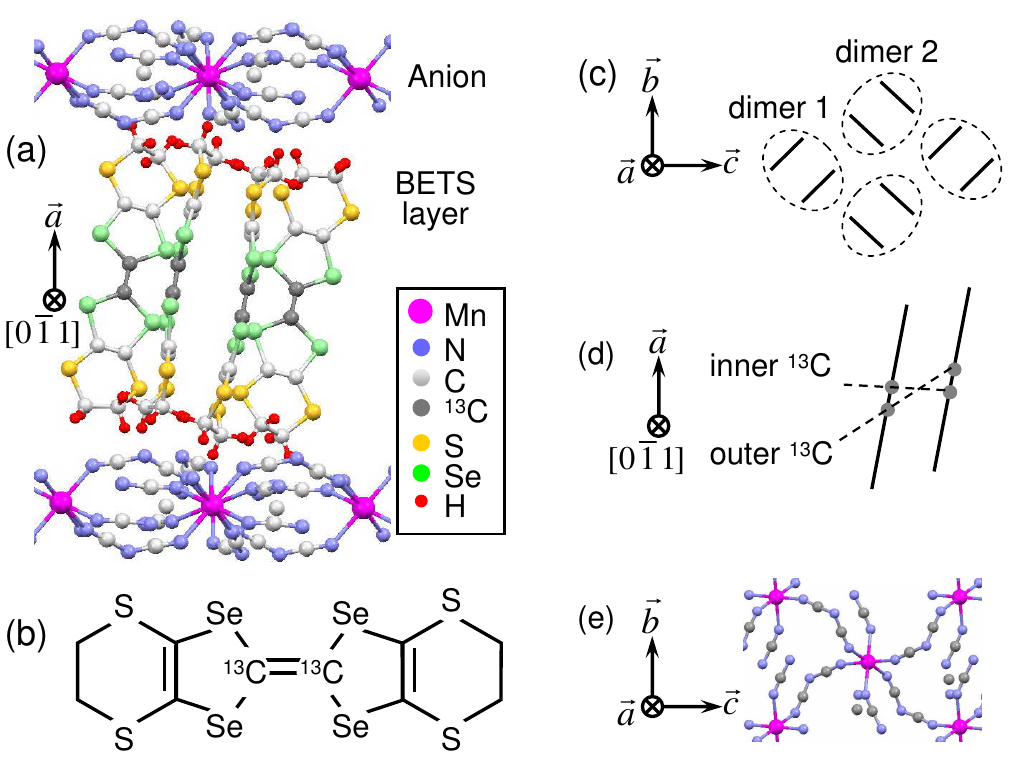
( b ) BETS molecule with 13 C in positions of the central C = C bond; ( c ) Top view of schematic dimers; ( d ) Side view of BETS dimer with site definition of the central C = C carbons; ( e ) Top view of the anion